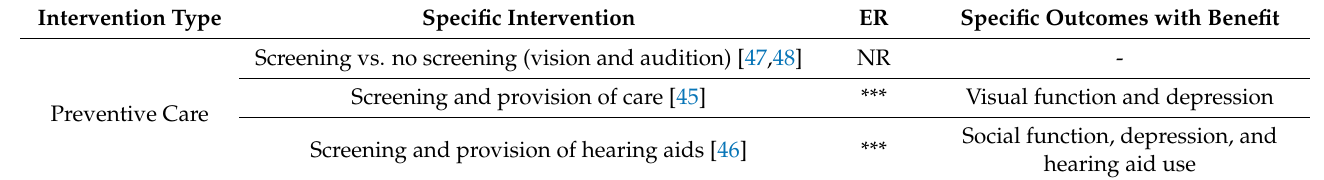
Table 1. Identified interventions for sensory capacities (vision and audition).